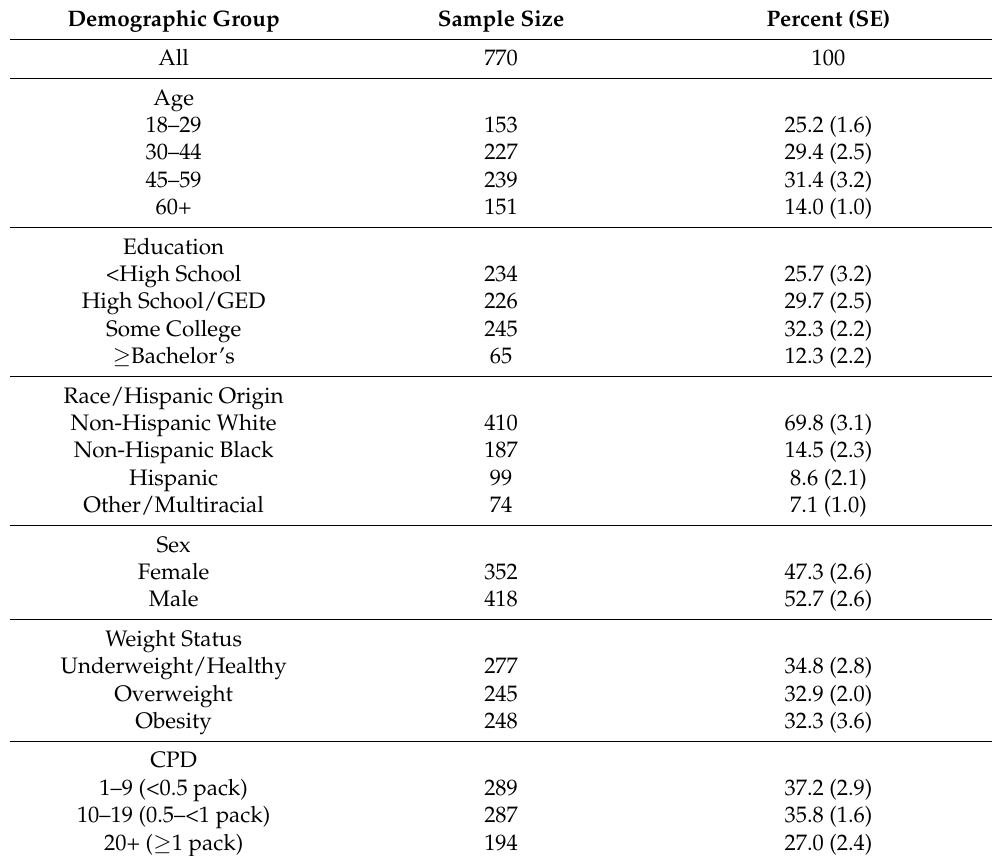
Table 1. Demographic characteristics of the participants and weighted percentages of population with the standard error (SE) of